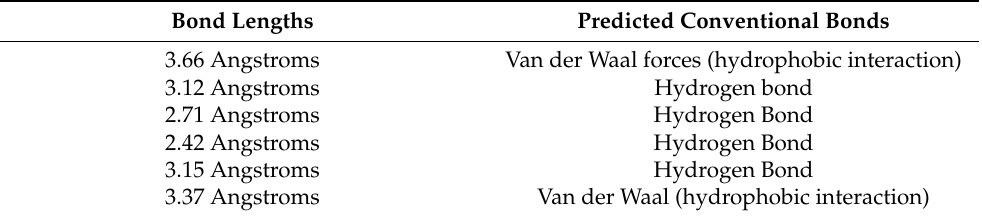
Table 1. Prediction of type of bonds and their lengths in docked complex through Discovery Studio.